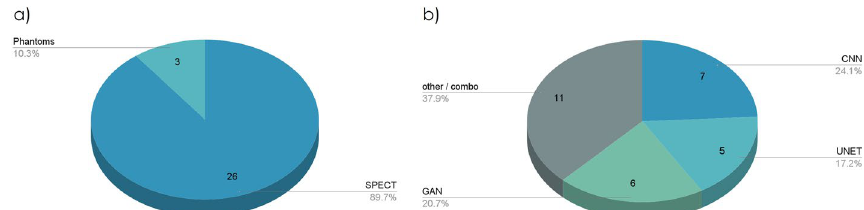
Fig. 7 Proportion of image quality improvement studies in terms of: a learning type (CNN, GANs, UNET or combinations of them), b data source (SPECT images and